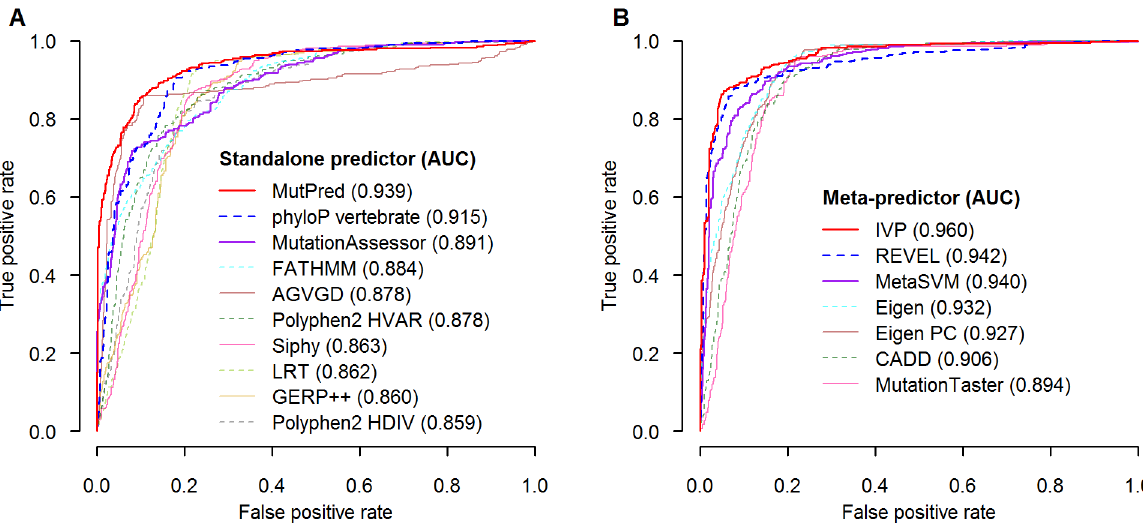
Fig 3. Comparison of AUC statistics of standalone and meta in silico predictors in MGPT data. ( A ) AUC statistics of top 10 standalone in silico predictors. ( B ) AUC statistics of 7 meta in silico predictors. The analysis models in legend were listed in descending order of AUC values.